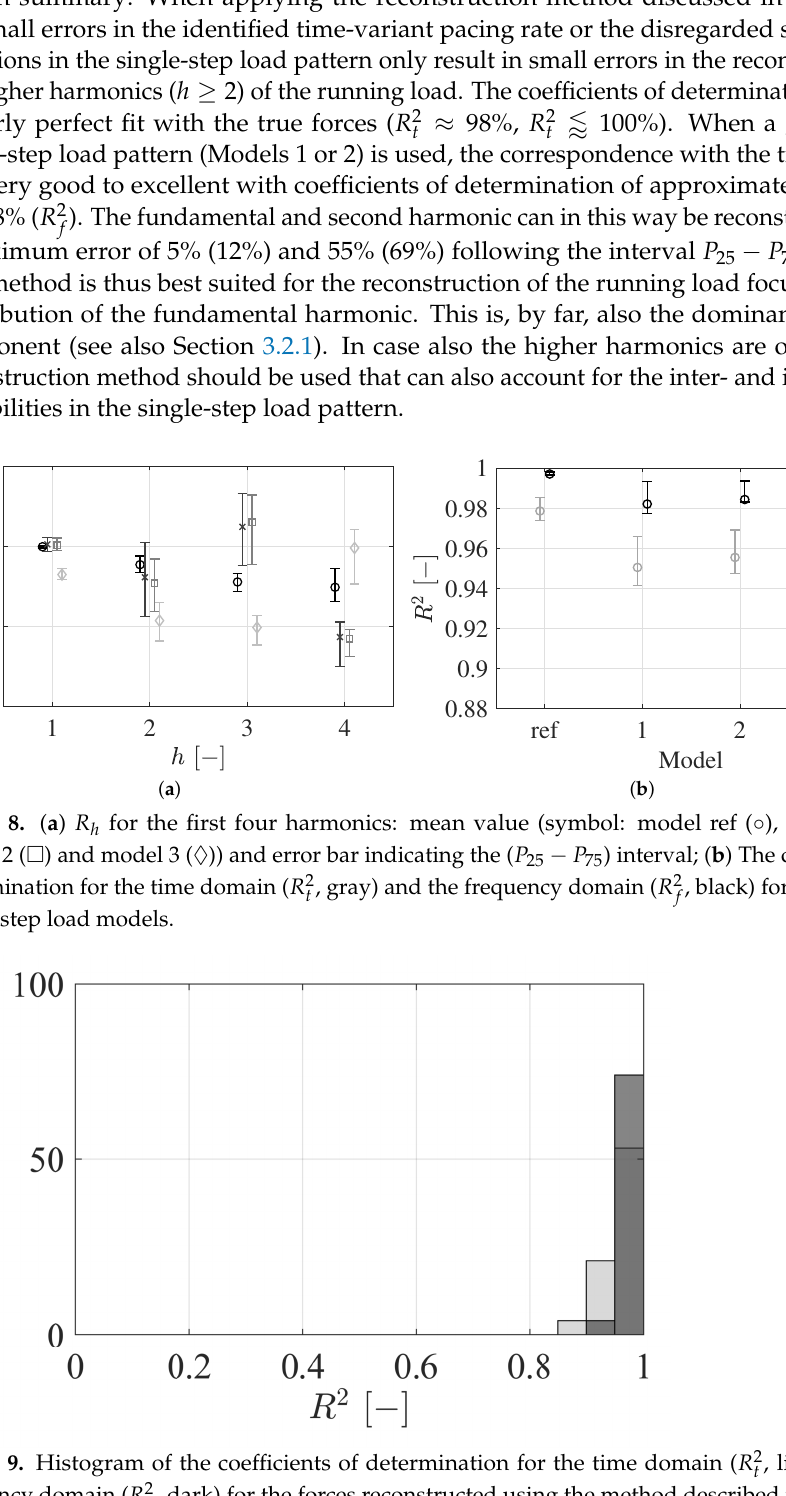
, light) and the t